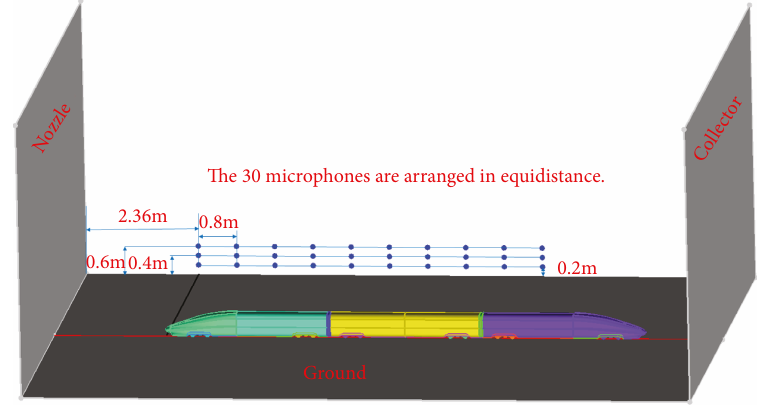
Figure 7: Thirty far- fi eld microphone positions.